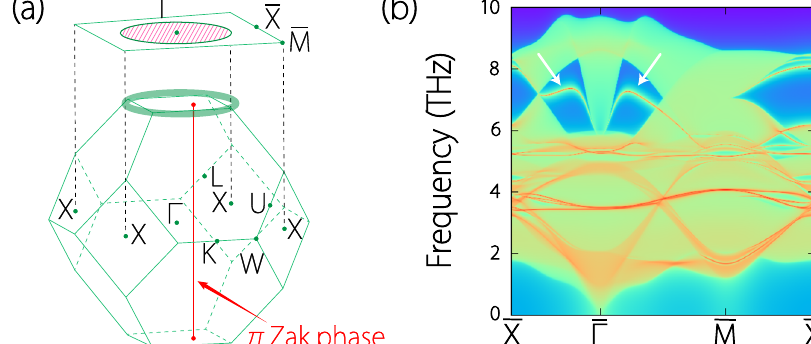
Fig. 4 Calculated surface phonon spectrum for the (001) surface of K 2 O. a K 2 O ’ s BZ and the corresponding (001) surface BZ. A straight path passing through the nodal ring has a π Zak phase. This leads to protected drumhead surface modes. Here, we only show the ring in the horizontal plane. The analysis also applies to the other rings of the chain. b Calculated surface phonon spectrum for the (001) surface of K 2 O (without non-analytic correction). The arrows indicate the drumhead surface phonon modes.